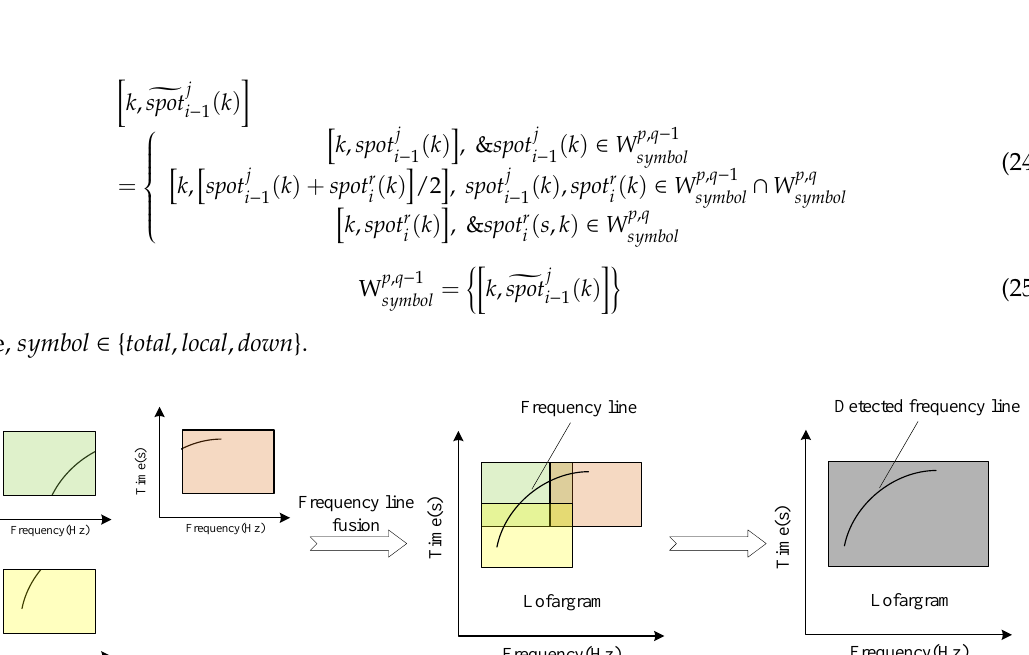
Figure 8. Frequency line fusion between adjacent sub-lofargrams. p , q − 1 part of W right